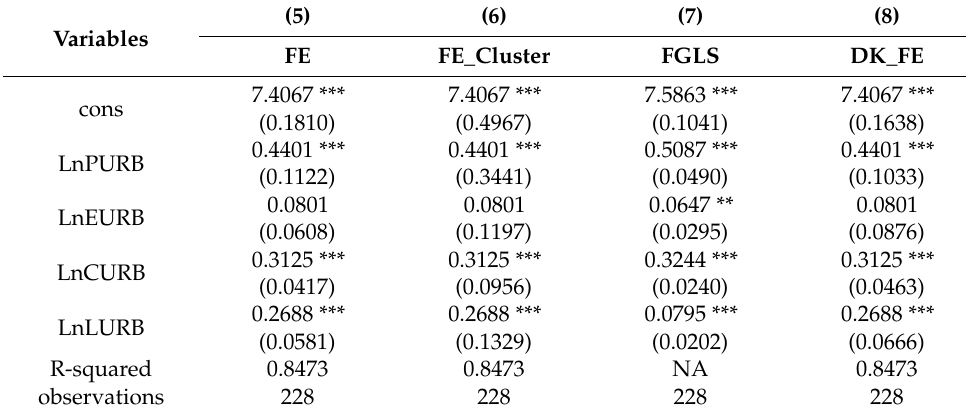
Table 11. Estimation results of eastern China’s panel data.